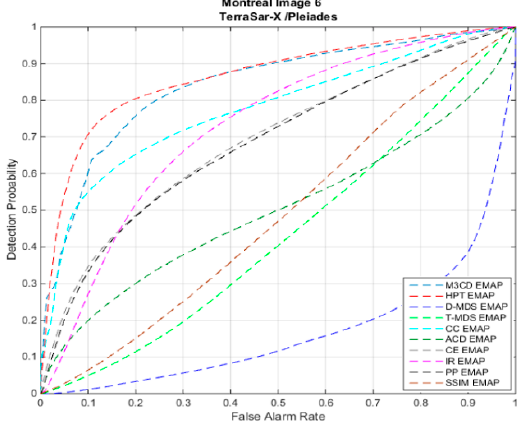
Figure 16. ROC curves for Image Pair-4 (SAR-Optical) with EMAP.